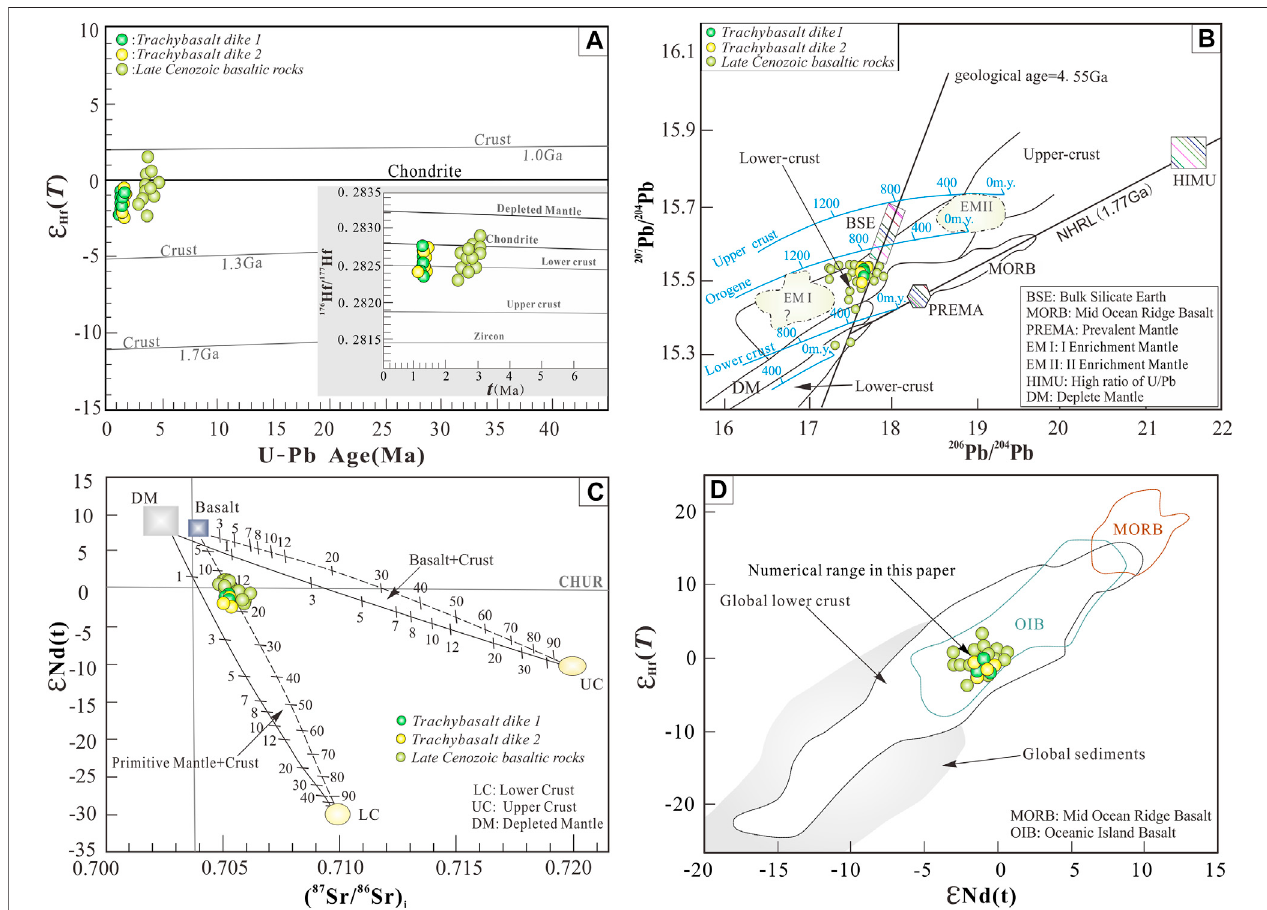
FIGURE 8 | (A) U-Pb age vs. ε Hf(t) of zircon diagram (after Bizzarro et al., 2002; Wu et al., 2007; Zou et al., 2008); (B) 207 Pb/ 204 Pb vs. 206 Pb/ 204 Pb diagram (after Zartman and Doe 1981); (C) ε Nd(t) vs. ( 87 Sr/ 86 Sr) i diagram (after Wu et al., 2002; Sun et al., 2014; Wang et al., 2017); the modeling results of assimilation of lower and uppercrustmaterialbyDMandbasalticmeltsarereportedasblacklines;thefractions(in%)ofassimilatedcrustalmaterialarereportedastickmarks; (D) ε Hf(t)vs. ε Nd(t) diagram (diagram modi fi ed after Dobosi et al., 2003 and Zhu, 2007). Other data sources are as for Figure 7 .